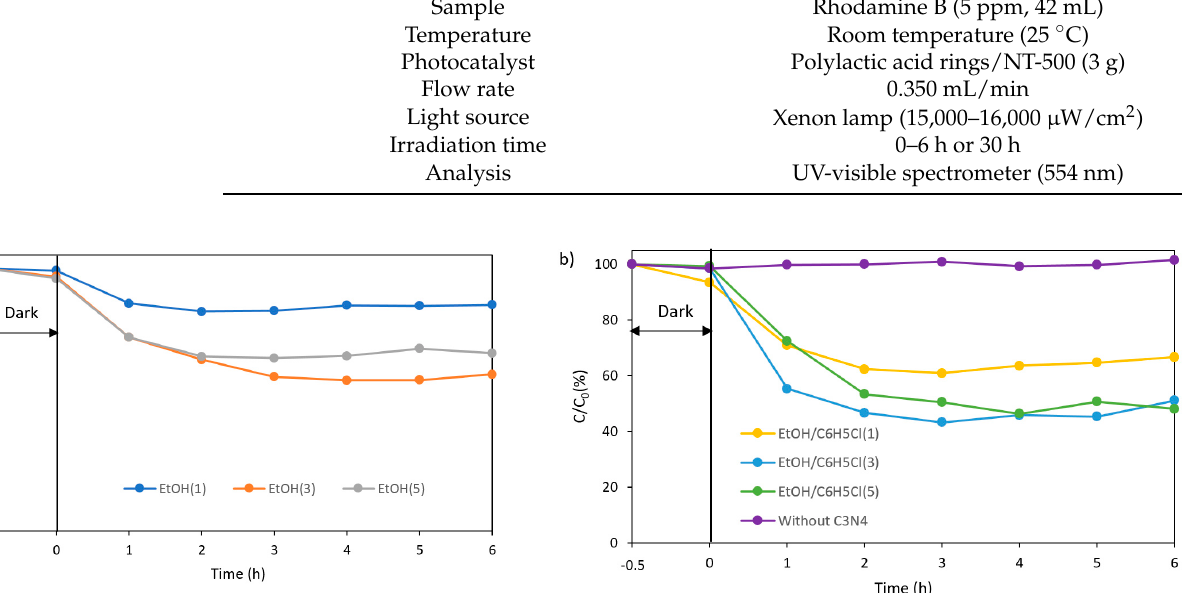
Figure 3. Photocatalytic RhB degradation of the NT-500 coating PLA prepared at different times of dip-coating ( a ) ethanol and ( b ) ethanol–chlorobenzene (flow rate 0.350 mL/min).